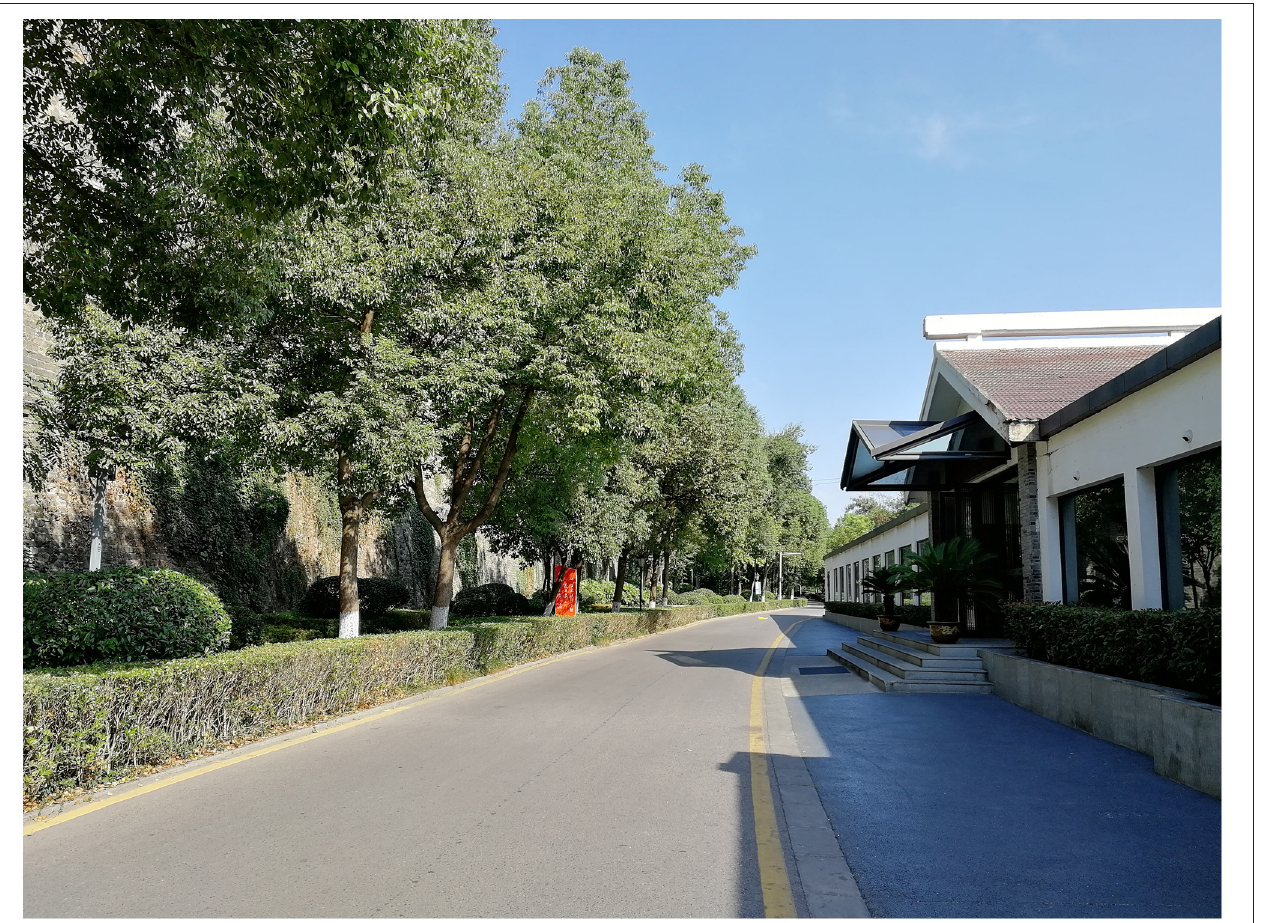
FIGURE 1 | The park site for the